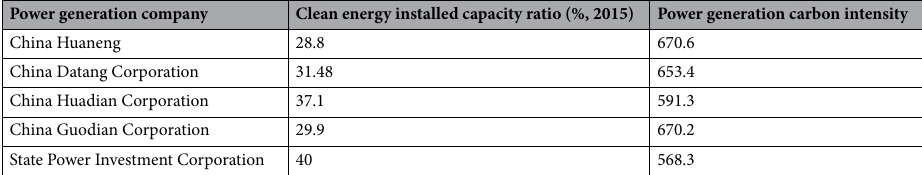
Power generation